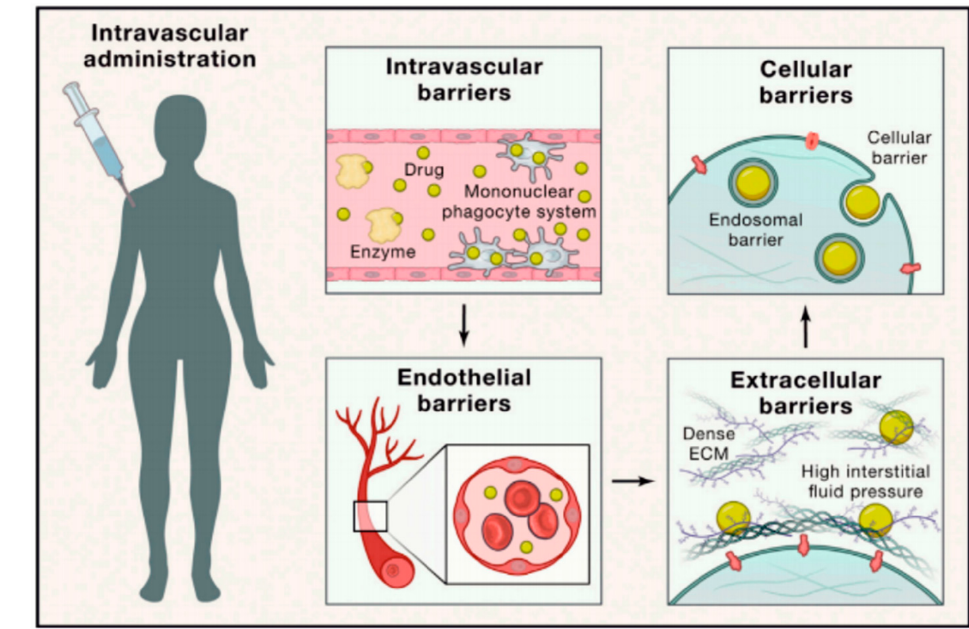
Figure 2. Biological barriers for site-specific drug delivery. Reprinted with permission from 16 © 2021 Published by Elsevier Inc. License number